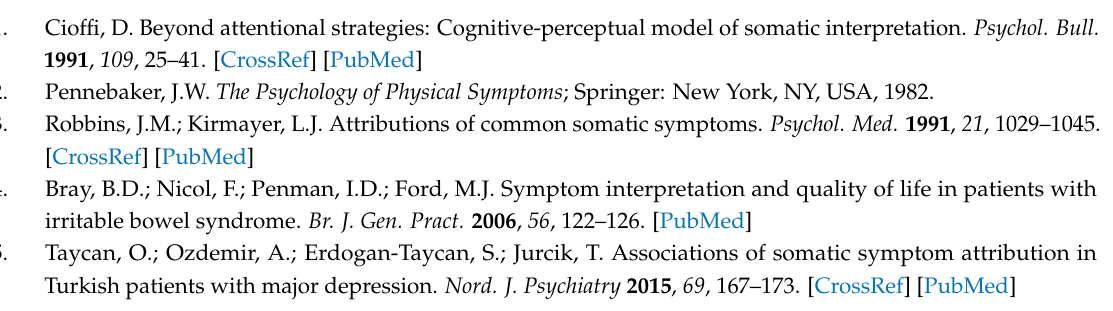
Table S1: SIQ-PR item means and standard deviations, Table S2: Hierarchical stepwise regressions to confirm significant associations between parent attributions and child variables whilst controlling for child age and